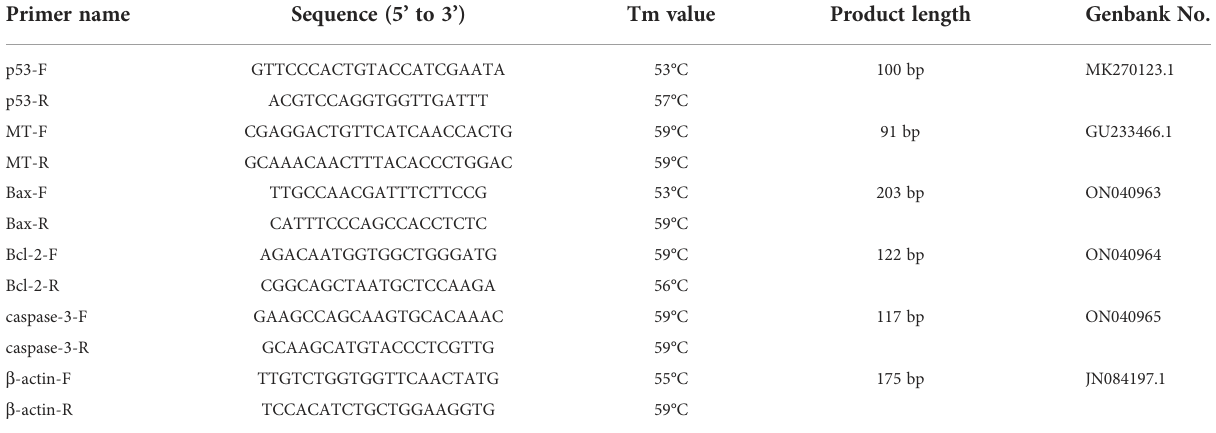
TABLE 1 Primers used for